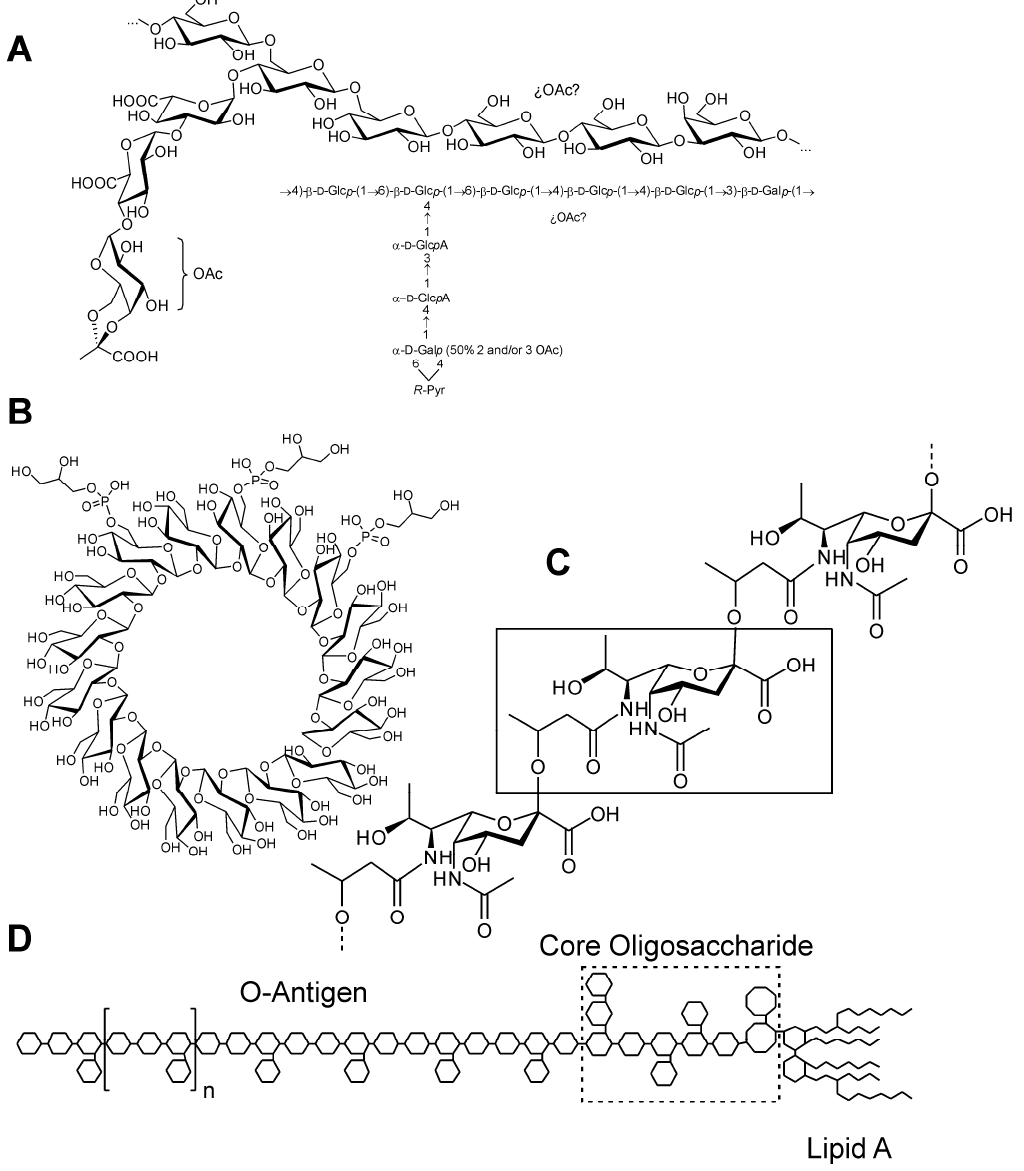
Figure 2. Structure of different Sinorhizobium fredii HH103 surface polysaccharides whose symbiotic